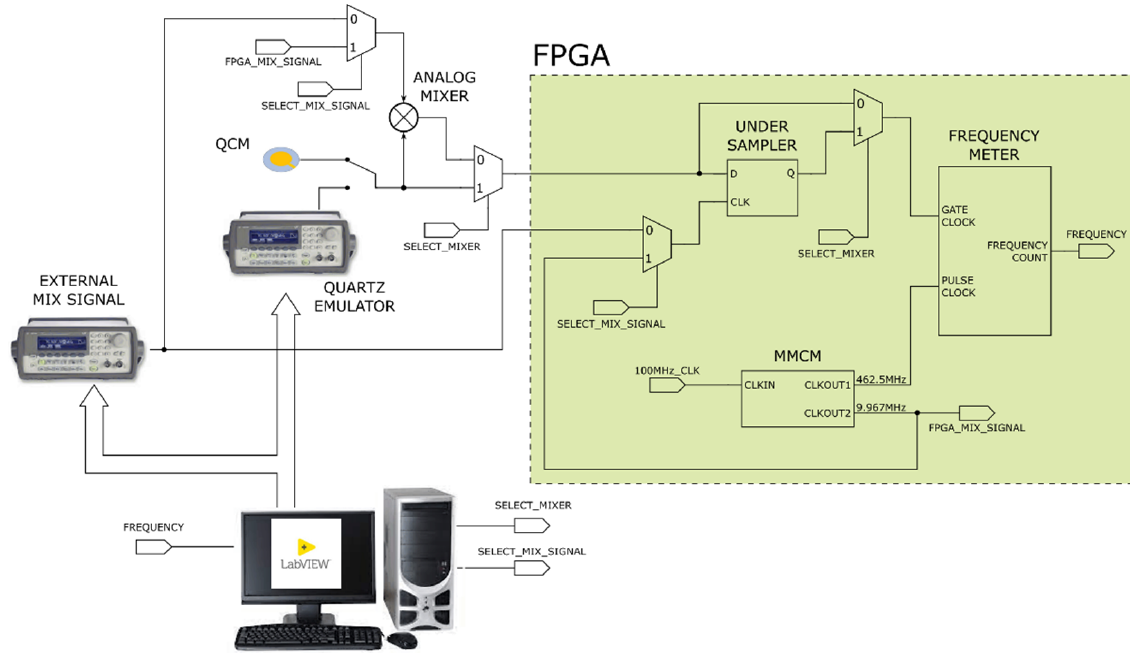
Figure 5. Functional block diagram of the frequency meter testbench.